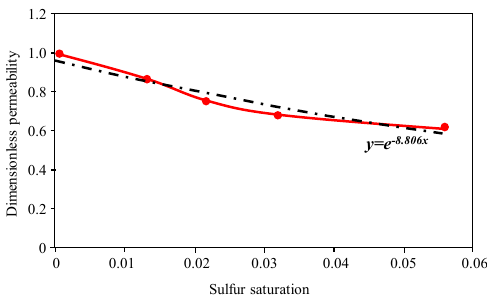
Figure 4. Figure 4. Sulfur saturation compared to dimensionless permeability used to calculate the reservoir damage.